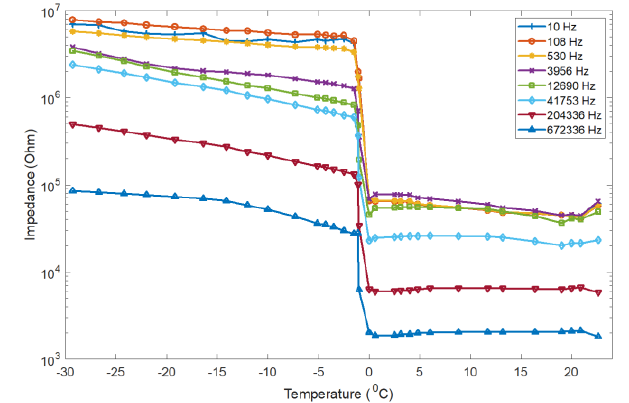
Figure 1: De-ionized water impedance at selected frequencies as a function of temperature measured during freezing.